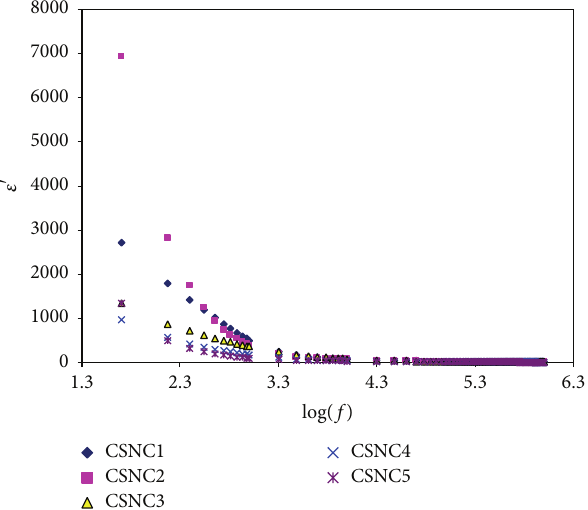
Figure 10: Composition dependence of dielectric constant for ( 1 − 0.02 ≤ 𝑥 ≤ 0.1 ) NCPEs at room 𝑥 )(0.9CS: 0.1LiTf)- 𝑥 Al 2 O 3 ( temperature.